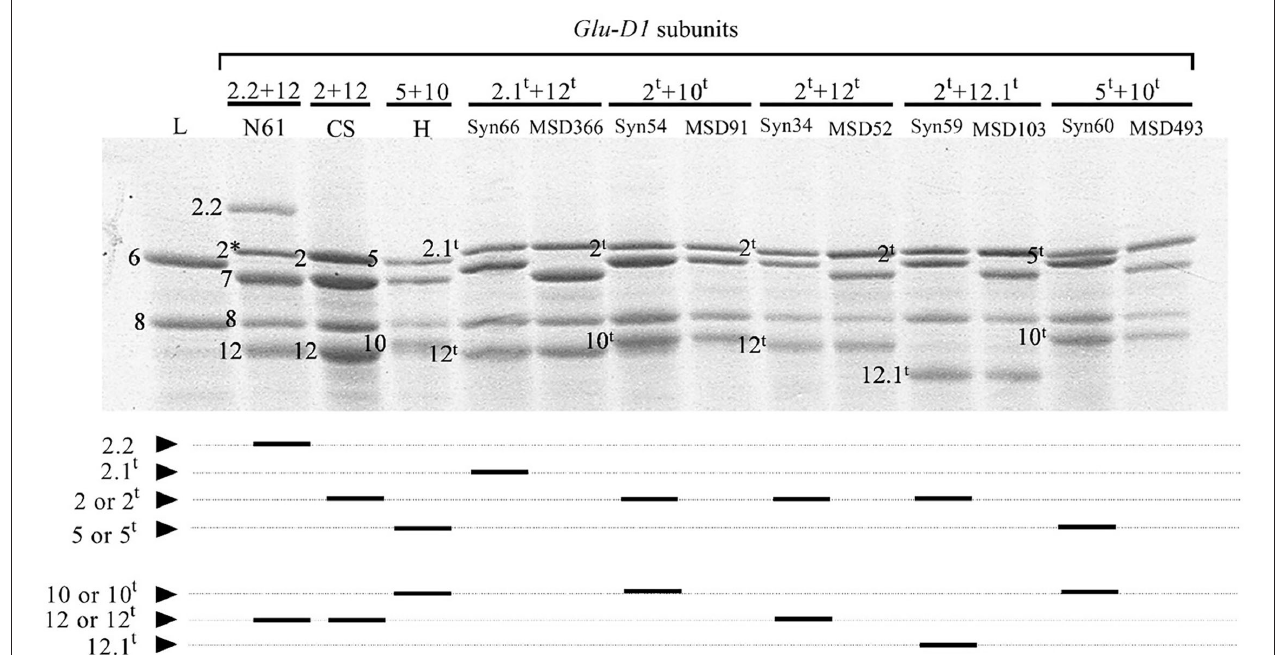
FIGURE 1 | Expression of HMW-GS derived from Aegilops tauschii in (upper panel) SDS-PAGE and (lower panel) a schematic diagram. N61, Norin 61; L, Langdon; CS, Chinese spring; H, Haruhikari; Syn, synthetic hexaploid line; MSD, multiple synthetic derivatives.